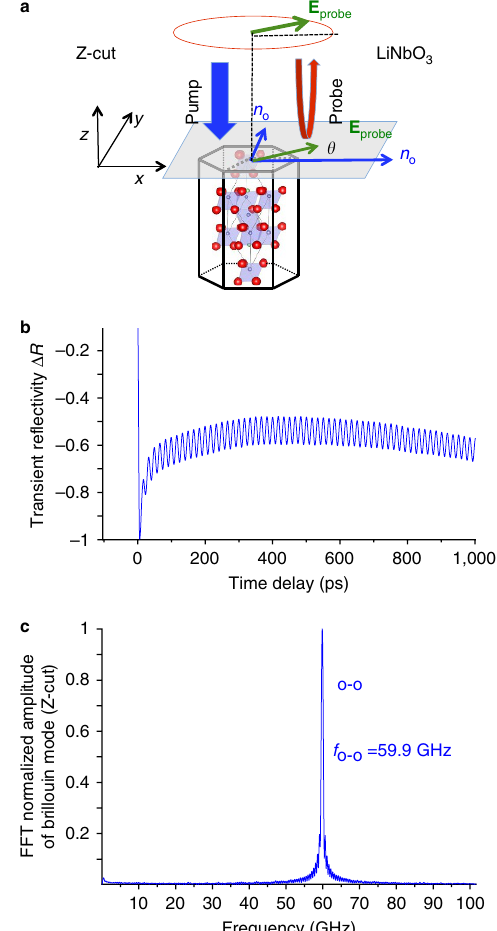
Figure 4 | Ultrafast elasto-optic detection in Z -cut LNO. ( a ) Sketch of the pump–probe experiment carried out on Z -cut LNO with OA along the z axis. ( b ) Time-resolved Brillouin signal and ( c ) its corresponding FFT of Z -cut LNO crystal revealing only the (o)-(o) process whatever the probe polarization angle ( E probe ).